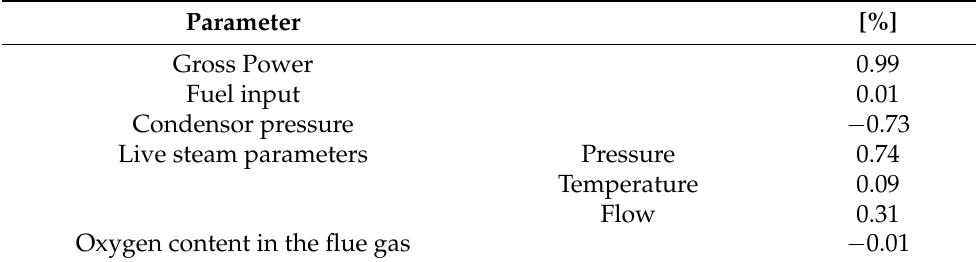
Table 4. Final deviation between the full model and the P max